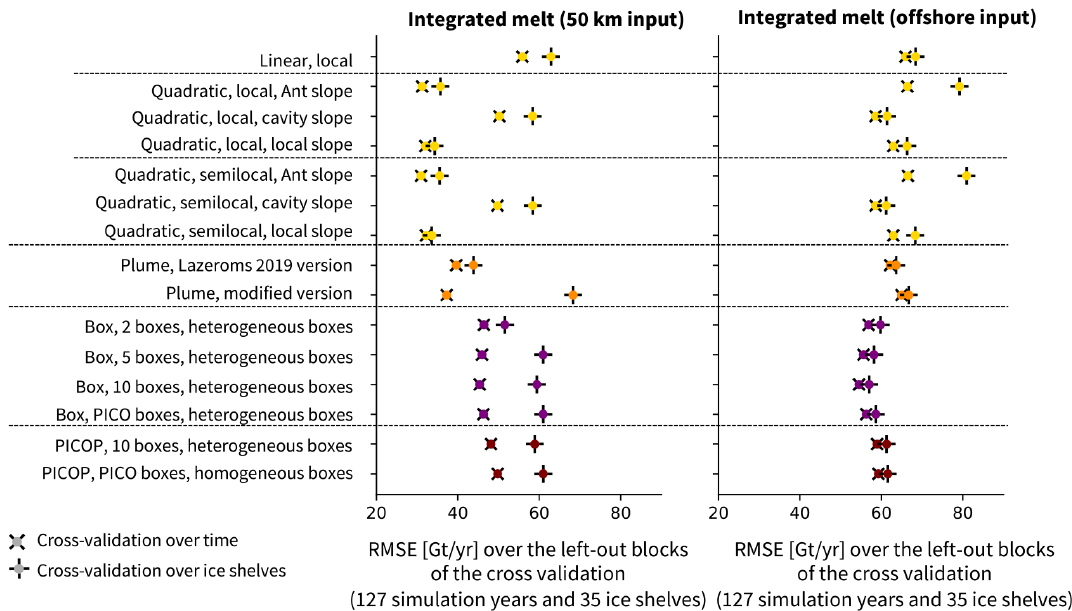
Figure 4. Summary of the RMSE of the integrated melt (RMSE int ) (in gigatonnes per year) for the cross-validation over time ( × ) and for the cross-validation over ice shelves ( + ) for a selection of parameterisations, using the 50km domain (left) and the offshore domain (right). The colours represent the different parameterisation approaches: simple (yellow), plume (orange), box (purple), and PICOP (brown). The RMSE is computed following Eq. (33) on the synthetically independent evaluation dataset (35 left-out ice shelves and 13 left-out time blocks). “Ant slope” stands for “Antarctic